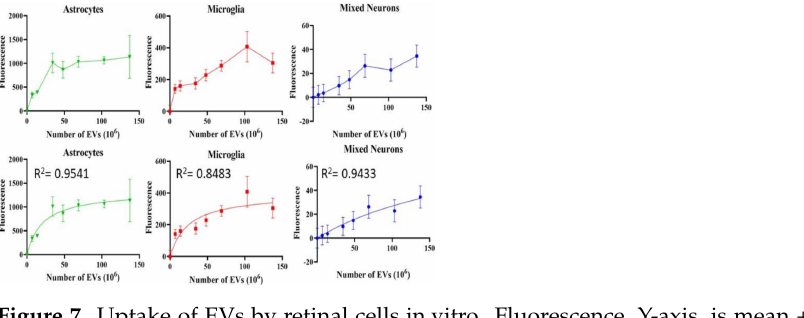
Figure 7. Uptake of EVs by retinal cells in vitro. Fluorescence, Y-axis, is mean +/ − SD. X-axis is number of EVs. Bottom row shows the fitted curves using non-linear regression. All demonstrate saturable, dose-dependent